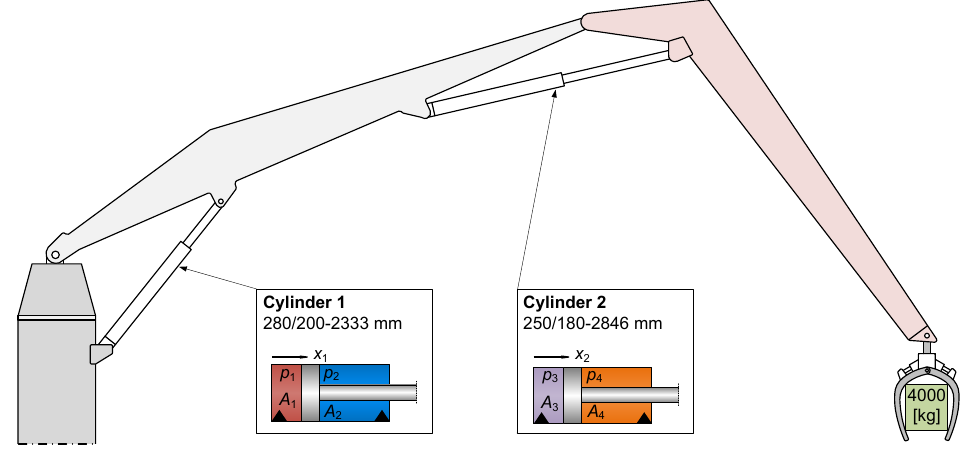
Figure 5. Hydraulically actuated crane used for case